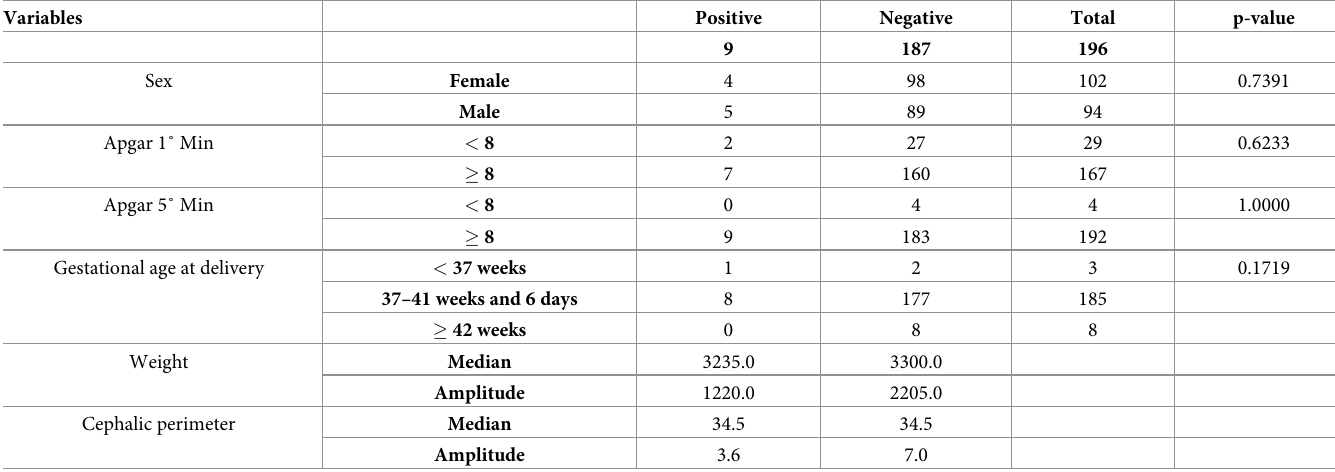
Table 4. Relationship for placenta RT-PCR results and newborn